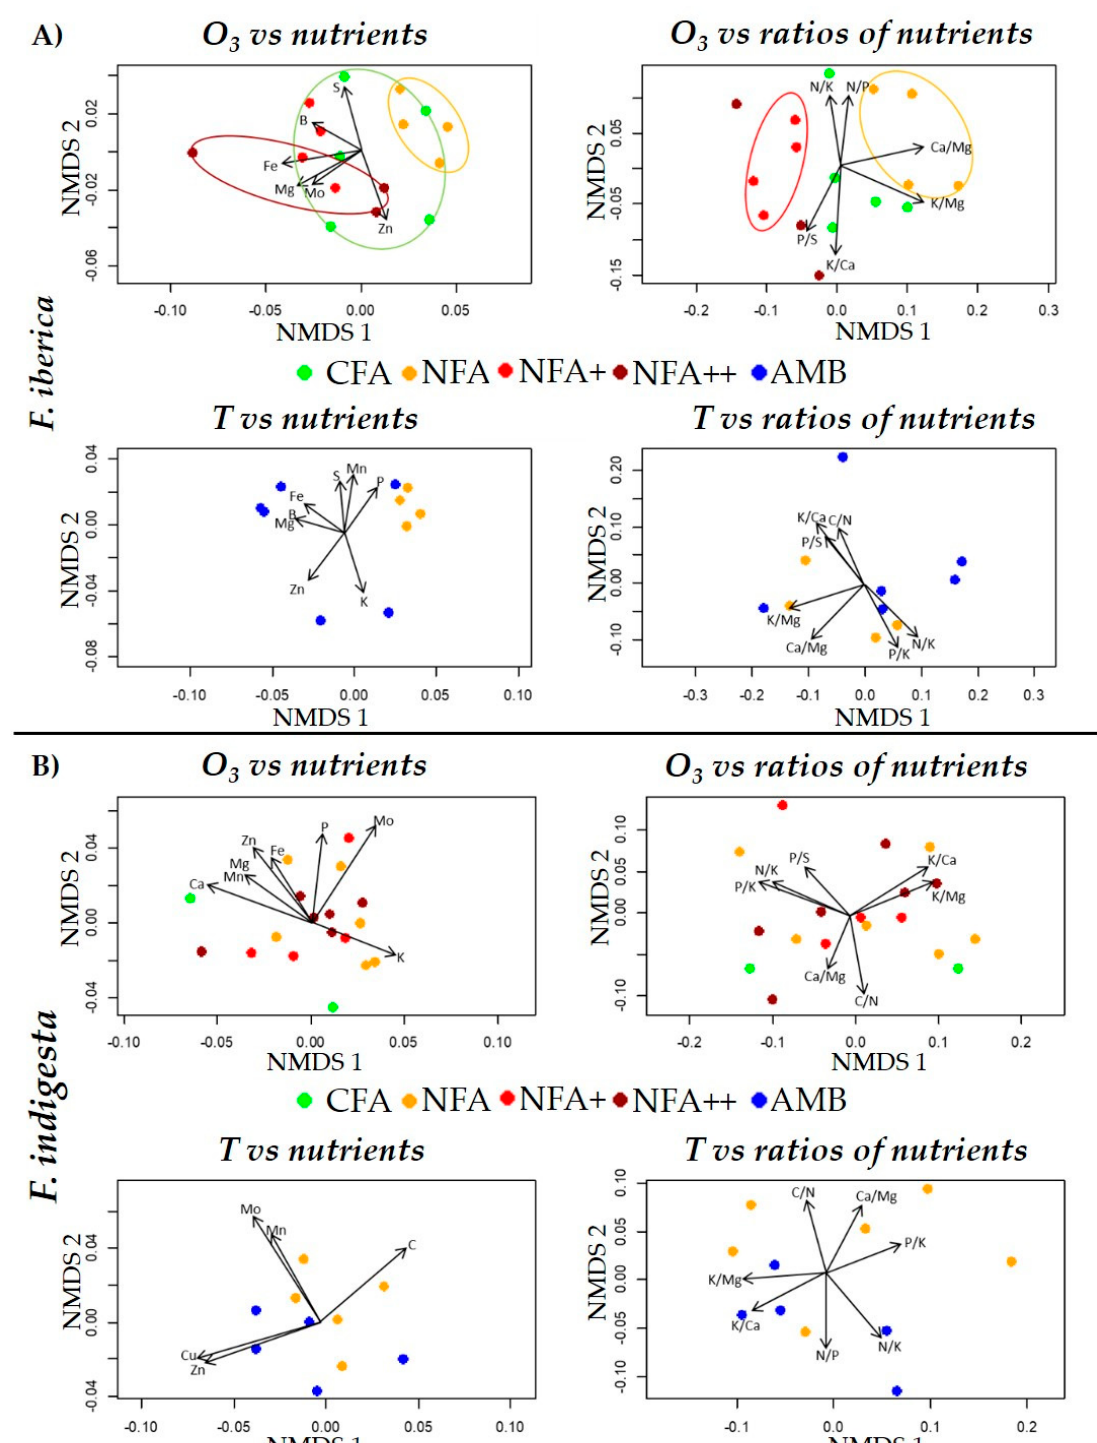
Figure 5. Non-metric multidimensional scaling (NMDS) of nutrients ( left ) and nutrient ratios ( right ) found in F. iberica ( A ) and F. indigesta ( B ) in relation to ozone and temperature (T) factors. The presence of colored ellipse represents significant differences among treatments following PERMANOVA results. Arrows denote significant correlations of nutrient or nutrient ratios with the NMDS axis. P/K and P/S nutrient ratios were different in CFA compared with the rest of the O 3 treatments in A. castellana (F 3, 19 = 3.02, p = 0.01). In S. tenacissima , only CFA and NFA were marginally different (F 3, 19 = 2.06, p = 0.07) due to different P/S, N/K, P/K, Ca/Mg,